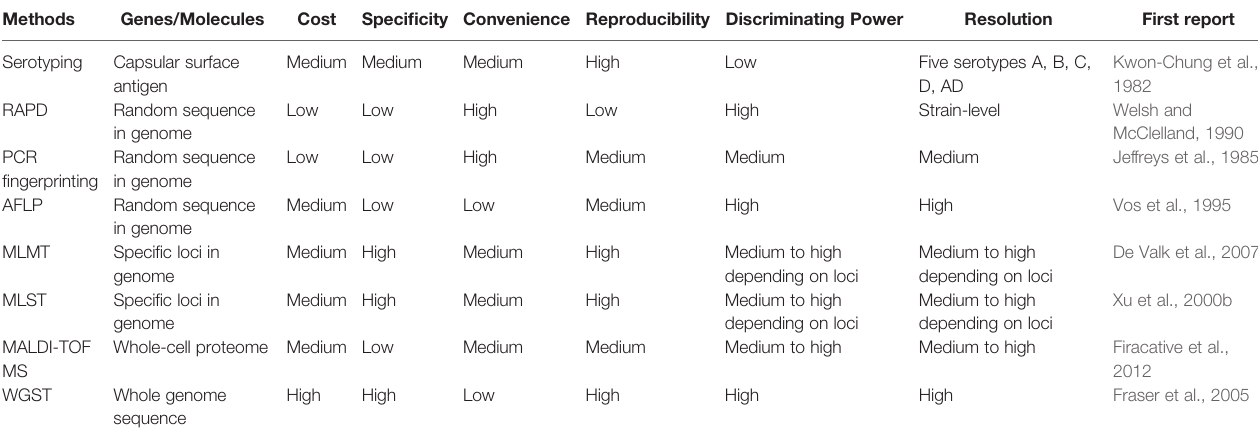
TABLE 1 | Comparison of major molecular methods used for typing the human pathogenic Cryptococcus